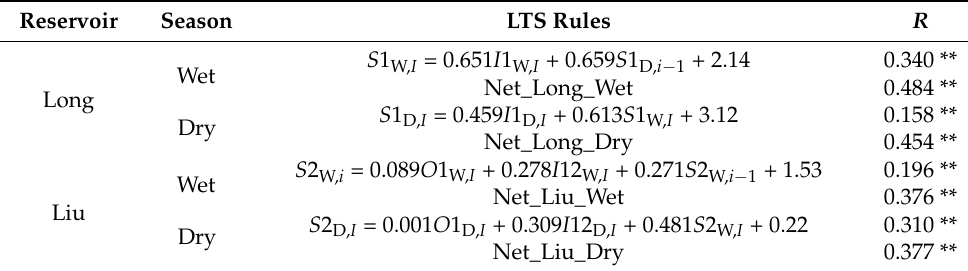
Table 3. MLR and ANN rules of Long and Liu